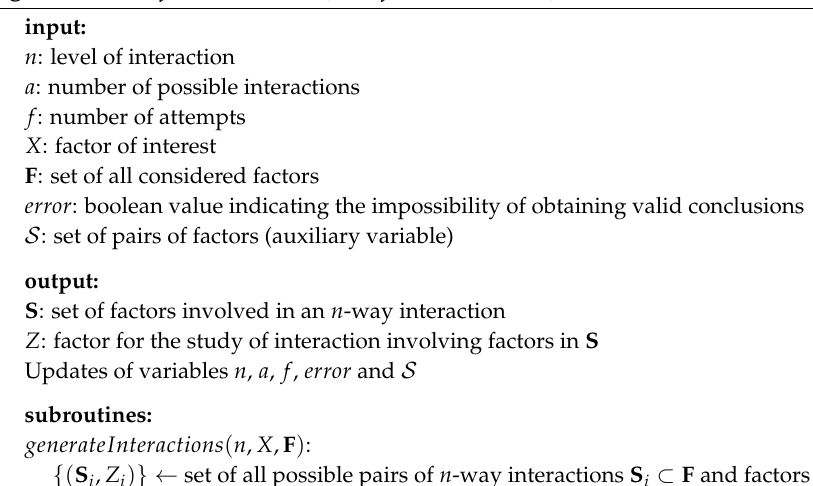
Algorithms A2. forceInteraction ( n , a , f , X , F , error , S